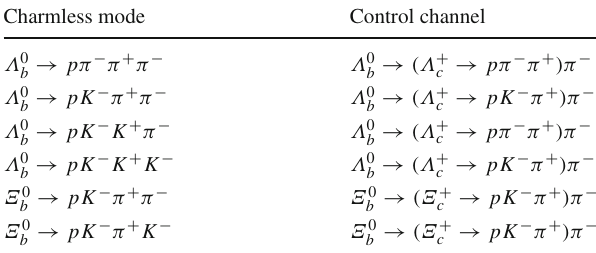
Table 1 Four-body charmless and charmed decays considered in this analysis.Thedifferenceof CP -asymmetriesmeasuredforthecharmless modes and for the control channels results in Δ A CP measurements. For each observable, the choice of the control channel is aiming at cancelling at first order production and detection asymmetries. Given the data samples at hand, it is not possible to meet both criteria for the → pK − π + K − : the choice of the signal decay Ξ 0 b